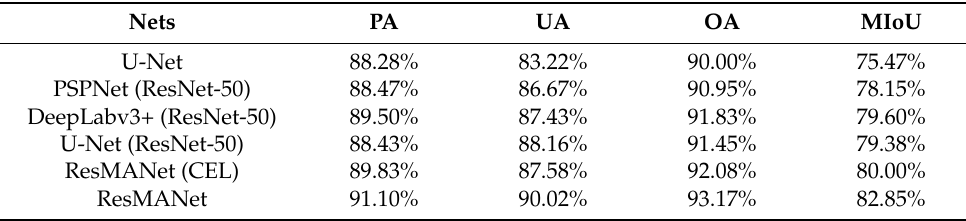
Figure 14. Confusion matrices of validation data in Dataset B. ( a ) ResMANet. ( b ) U-Net. ( c ) PSPNet (ResNet-50). ( d ) DeepLabv3+ (ResNet-50). ( e ) U-Net (ResNet-50). ( f ) ResMANet (CEL). SC1: Farmland, SC2: Woodland, SC3: Grassland, Table 5. Accuracy assessment of Hainan dataset B.